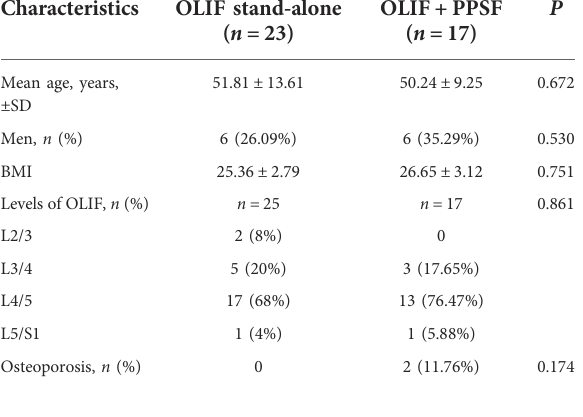
TABLE 1 General characteristics of the